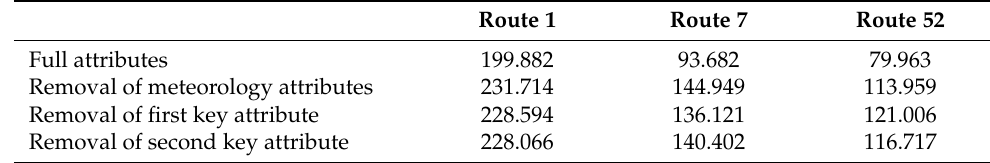
Table 11. Results of sensitivity analysis based on